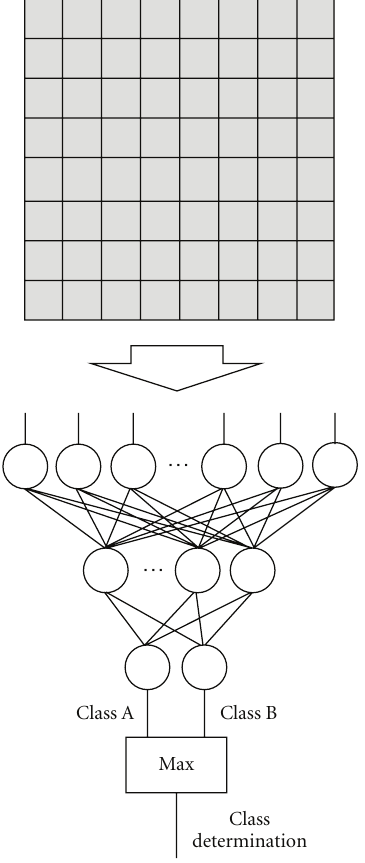
Figure 4: Architecture of a multilayer perceptron for character recognition. The binary pixel values in an image are entered as input to the multilayer perceptron. The class to which the given image belongs is determined as the class of the output unit with the maximum value.